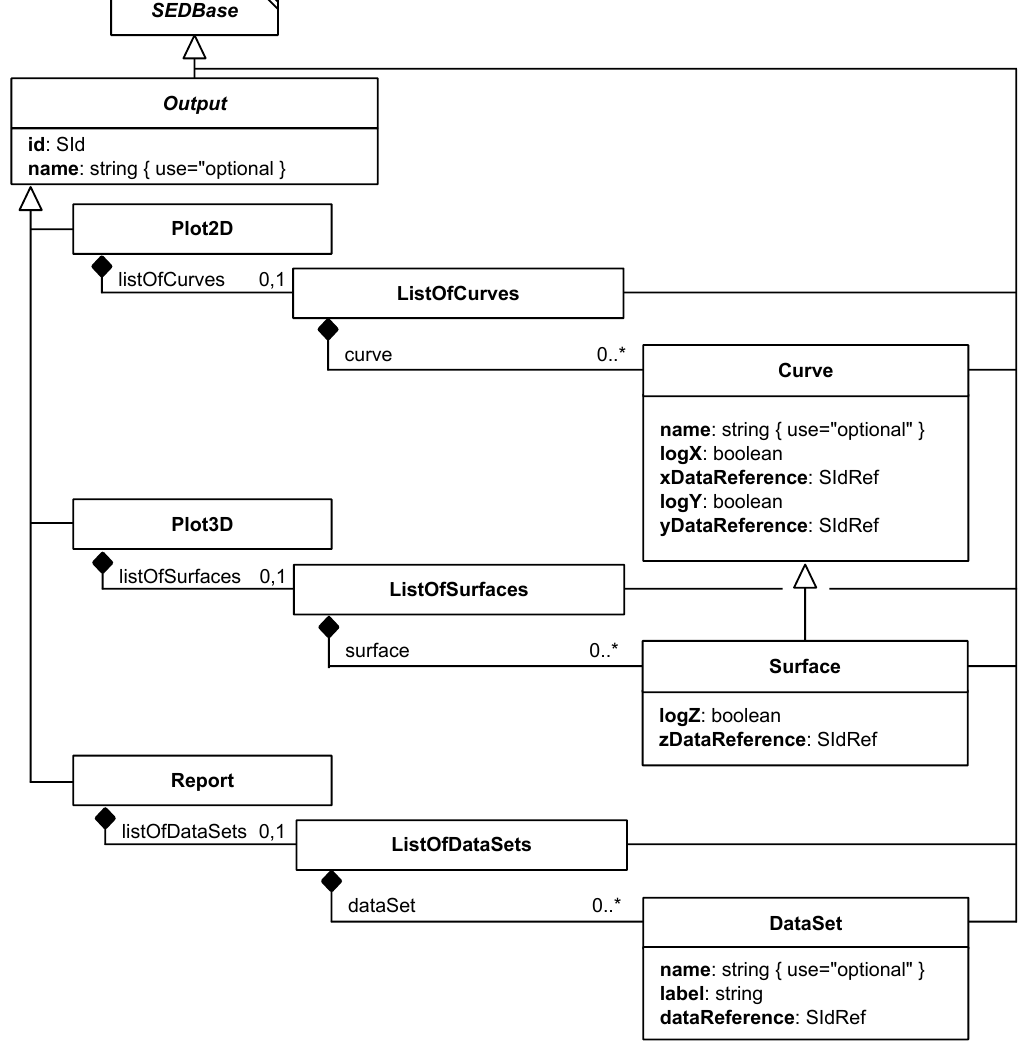
Figure 2.16: The SED-ML Output class. Note that ListOfCurves, Curve, ListOfSurfaces, Surface, ListOfDataSets, DataSet and DataGenerator are subclasses of SEDBase ; the respective inheritance connections are not shown in the